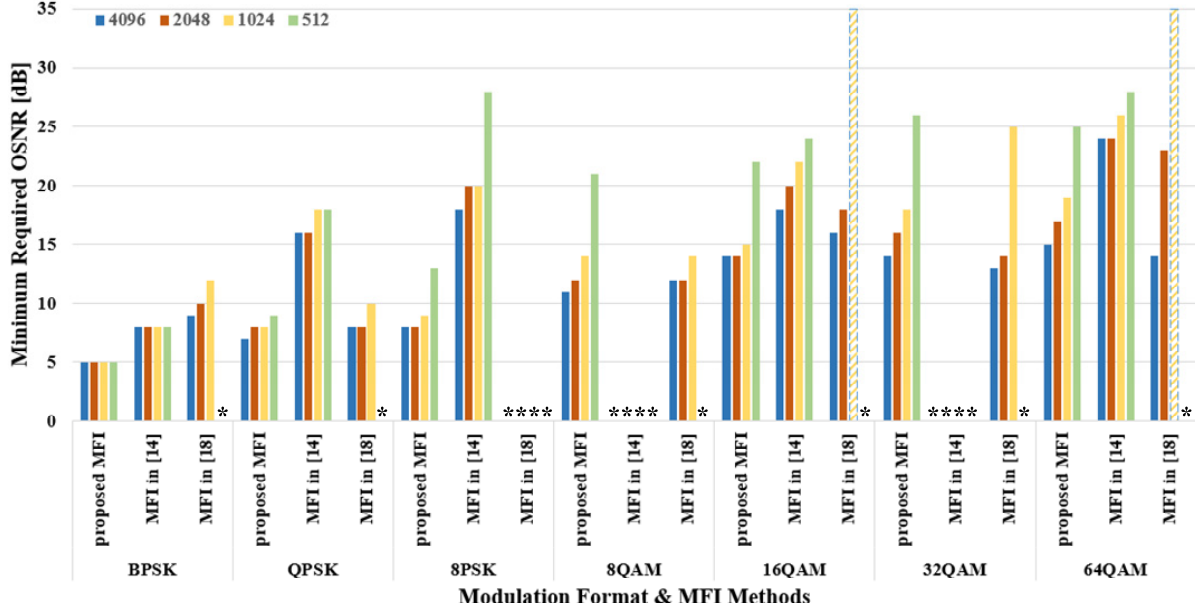
Figure 11. The comparison of the minimum required OSNR to achieve 100% accuracy for different MFI methods, under a different number of samples. MFI methods, under a different number of